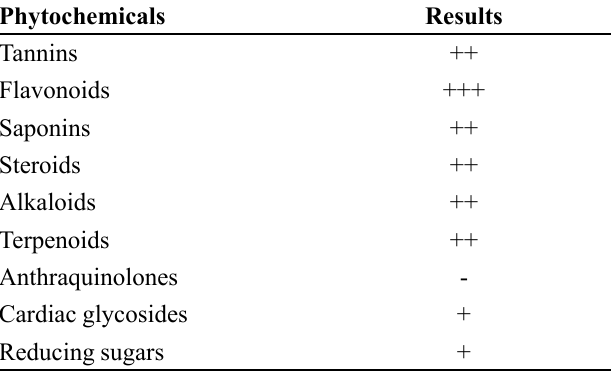
TABLE I - Qualitative phytochemistry